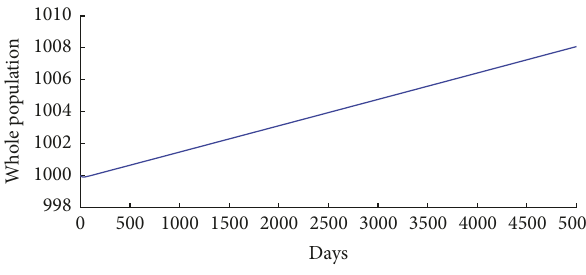
Figure 6: Whole population in the SISV model without vaccination when the basic reproduction number of its corresponding normal- ized SISV model is 𝑅 0 = 0.878 .